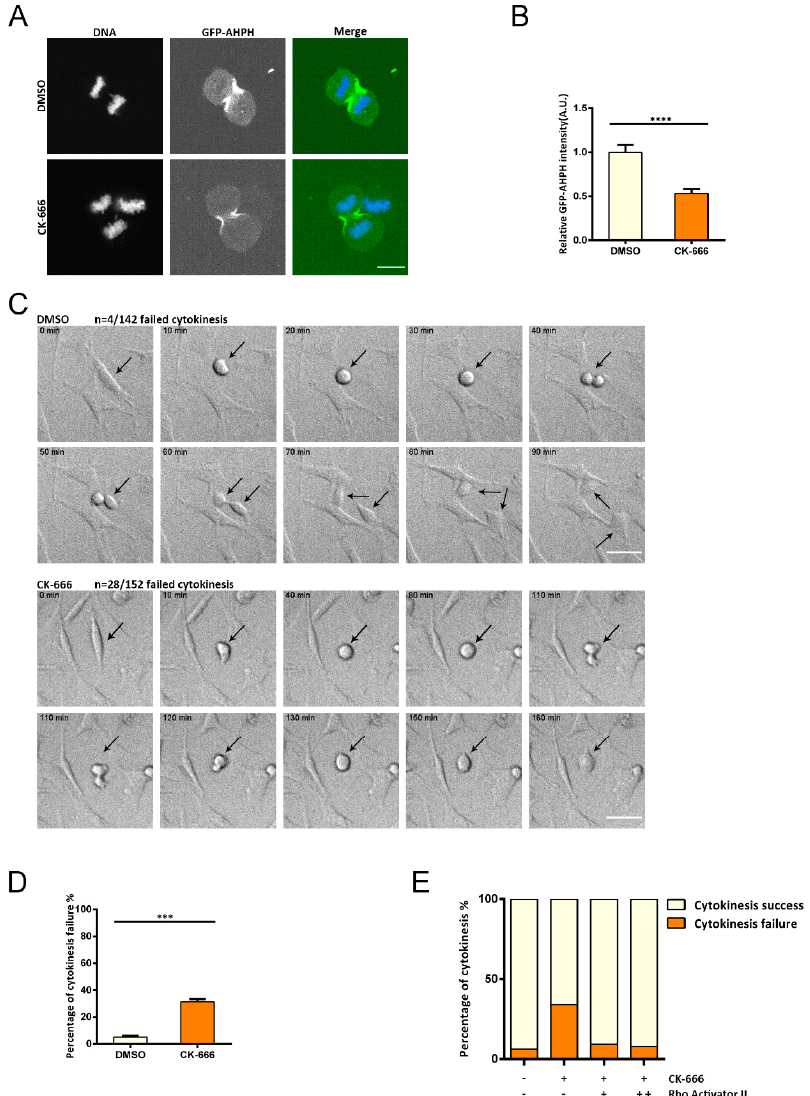
Figure 5. Increasing RhoA activity rescues cytokinesis defects induced by Arp2 / 3 inhibition. ( A ) Representative images of cells expressing GFP-AHPH in cytokinesis: DMSO or CK-666 were used. Scale bar is 10 µm. ( B ) Quantification of the GFP-AHPH level at the cytokinetic furrow: cells were treated with DMSO or CK-666. n = 13, **** p < 0.05 by student’s t test. ( C ) Differential interference contrast ( DIC) live imaging of DMSO- or CK-666-treated MEFs. The top two panels represent DMSO-treated cells, and the bottom two panels represent CK-666-treated cells. Arrows indicate single cell divisions after drug treatment; 142 cells treated with DMSO and 152 cells treated with CK-666 were scored, and the number of cytokinesis failure/total number of cytokinesis was quantified. Scale bar is 50 µm. ( D ) Quantification of percentage of cytokinesis failure treated with DMSO and CK-666. The error bar indicates SEM, *** p < 0.05, by student’s t test. n = 3 independent experiments. ( E ) Quantification of percentage of cytokinesis failure treated with DMSO, CK-666, CK-666 + 2 µg/mL Rho activator II, and CK-666 + 4 µg/mL Rho activator II.